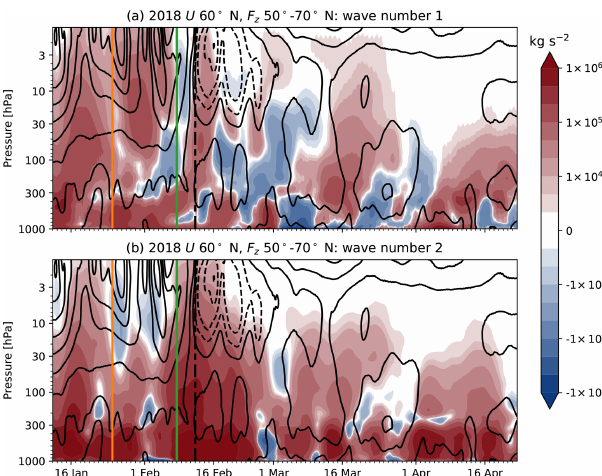
Figure 6. Wave forcing during the February 2018 boreal major warming. Shading shows the vertical component of the Eliassen– Palm flux averaged from 50–70 ◦ N from zonal wavenumbers (a) one and (b) two. Contour lines show zonal-mean zonal wind at 60 ◦ N; the contour interval is 10ms − 1 . The vertical dashed–dotted black line indicates the date of the wind reversal at 10hPa, 60 ◦ N. The vertical green and orange lines indicate the requested initializa- tion